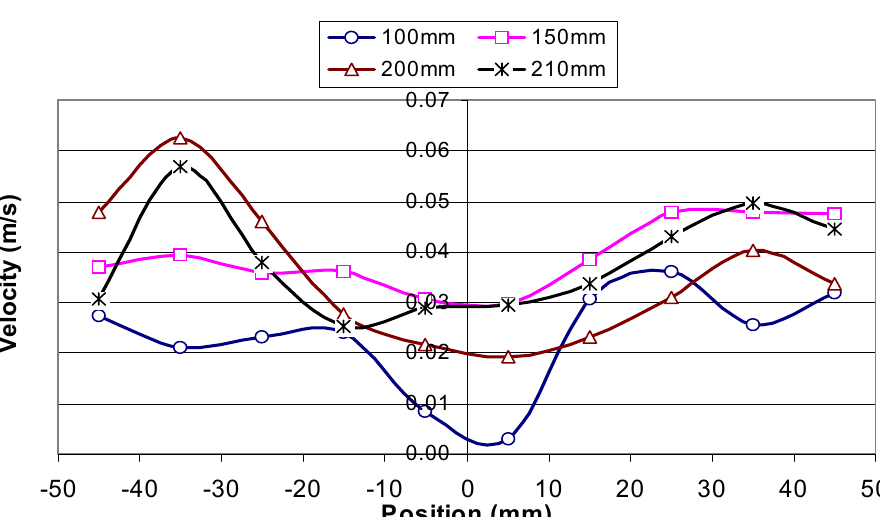
Fig. 13 : Y-direction velocity for 0-degree and without fire-tube